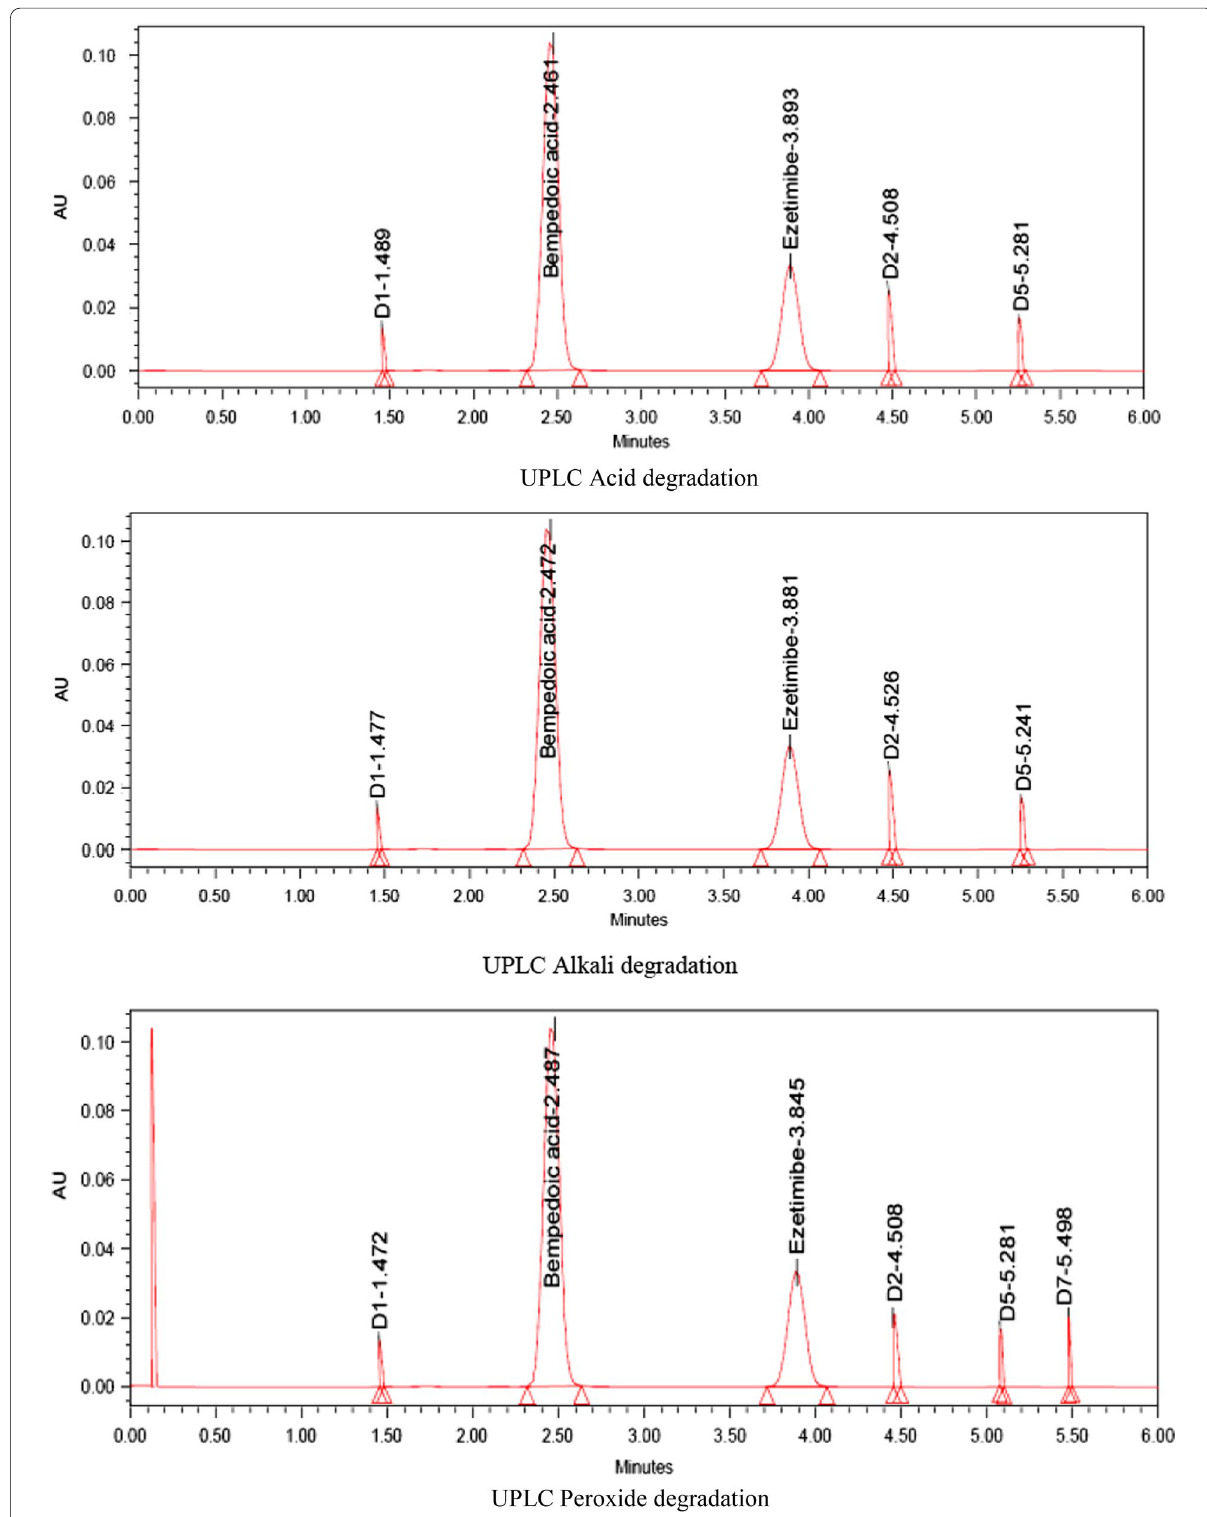
Fig. 5 UPLC degradation